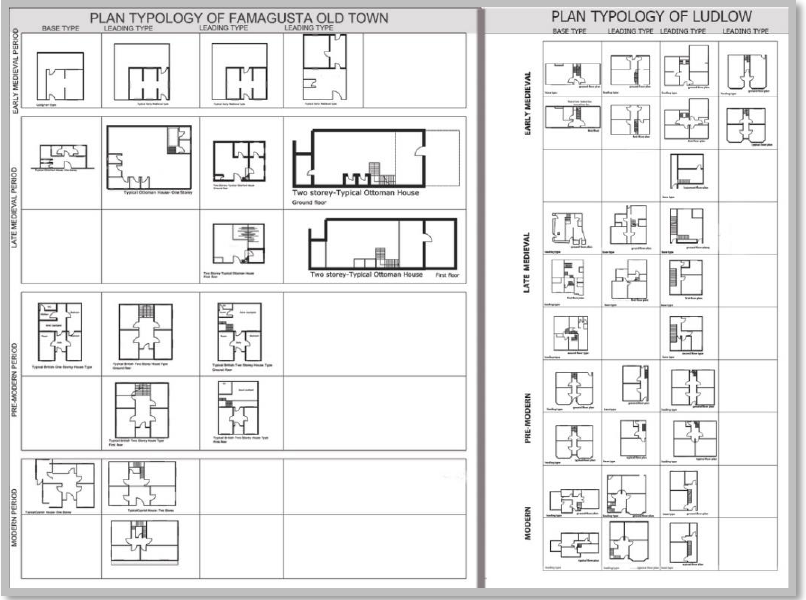
Figure 1 Plan Typology of Famagusta and Ludlow (Cömert,